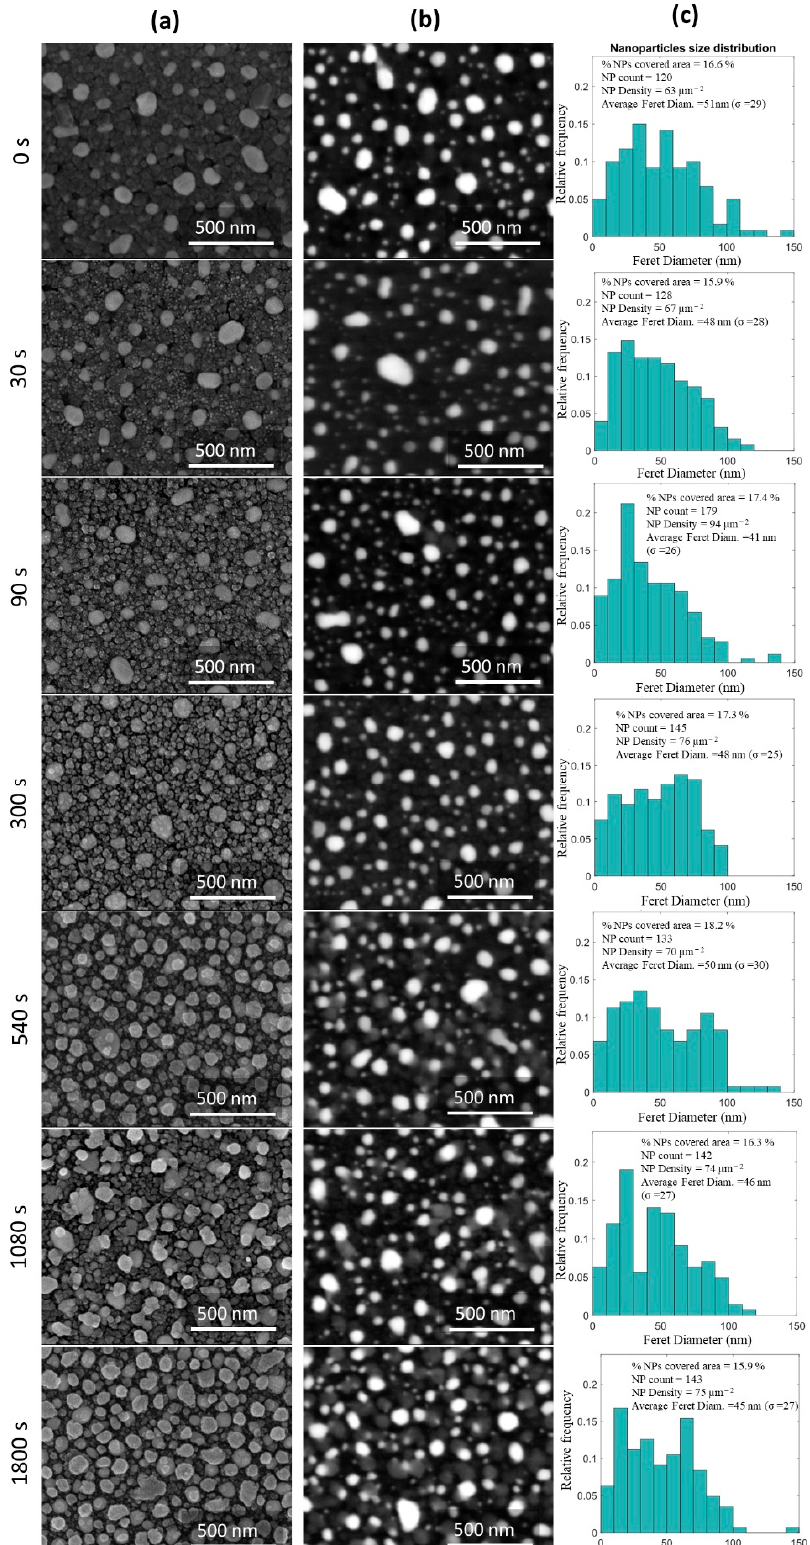
Figure 4. SEM micrographs of the Au:CuO thin films as a function of Ar plasma treatment time observed in top-view using ( a ) secondary (SE) and ( b ) gaseous analytical electron detectors with atomic weight contrast. The size distribution histograms of the Au NPs present in the micrographs with atomic weight contrast are displayed in ( c ).